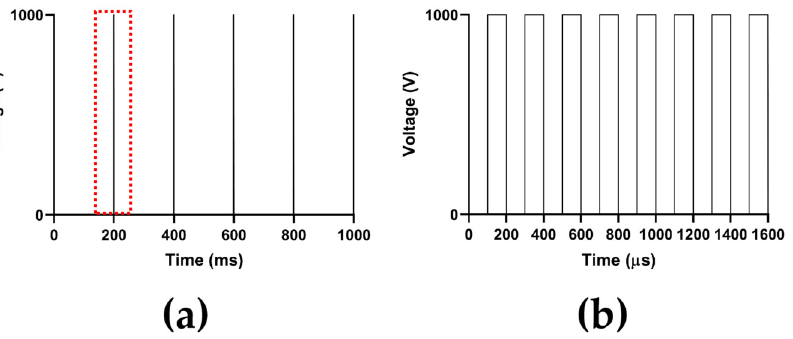
Figure 4. The waveform of P ( t ) in the computation of the temperature distribution, where ( a ) is the complete waveform of P ( t ) with a total duration of 1 s, and ( b ) is the detail of the complete waveform of a single pulse train in the red box of ( a ).